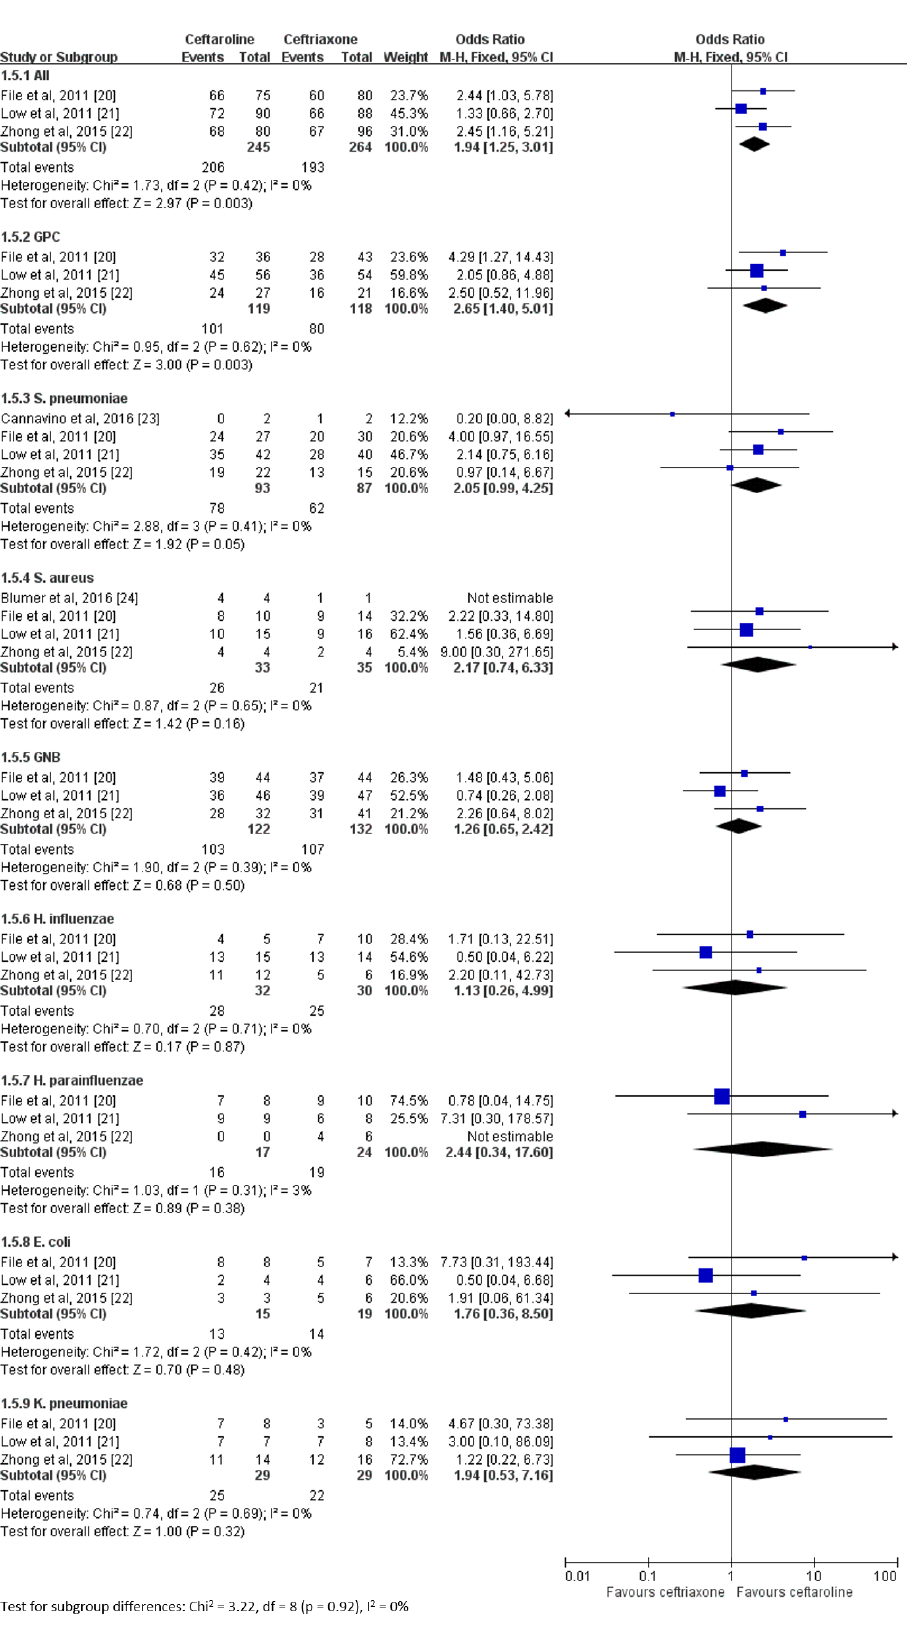
Figure 5. Overall clinical cure rates of ceftaroline and ceftriaxone for the treatment of community- acquired pneumonia based on pathogens.